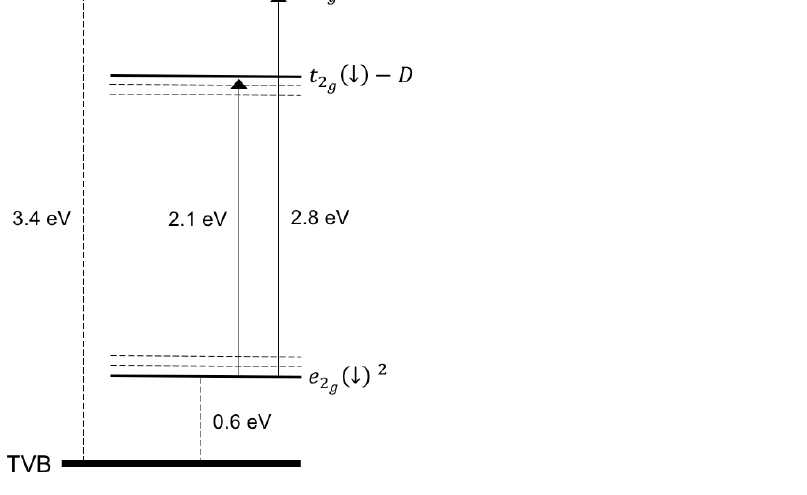
Figure 9. Schematic diagram showing electronic states induced by Co – V O and Co – D complexes (see the text) in the ZnO energy gap. TVB and CBM indicate the top of the valence band and the conduction band minimum, respectively. Reproduced with permission from [74]. Copyright 2019 Royal Society of Chemistry.